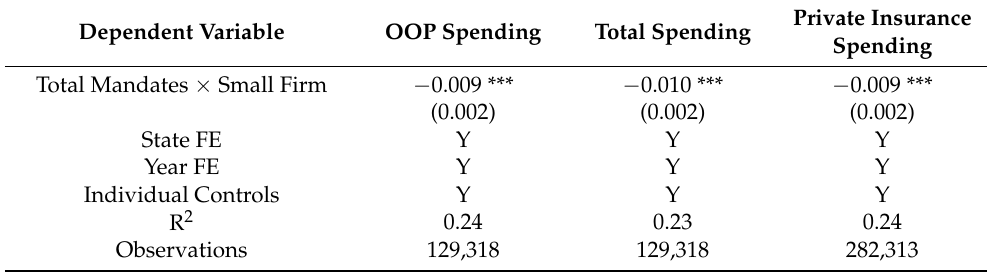
Table 2. Difference-in-difference effect of benefit mandates on health care spending. Dependent Variable OOP Spending Total